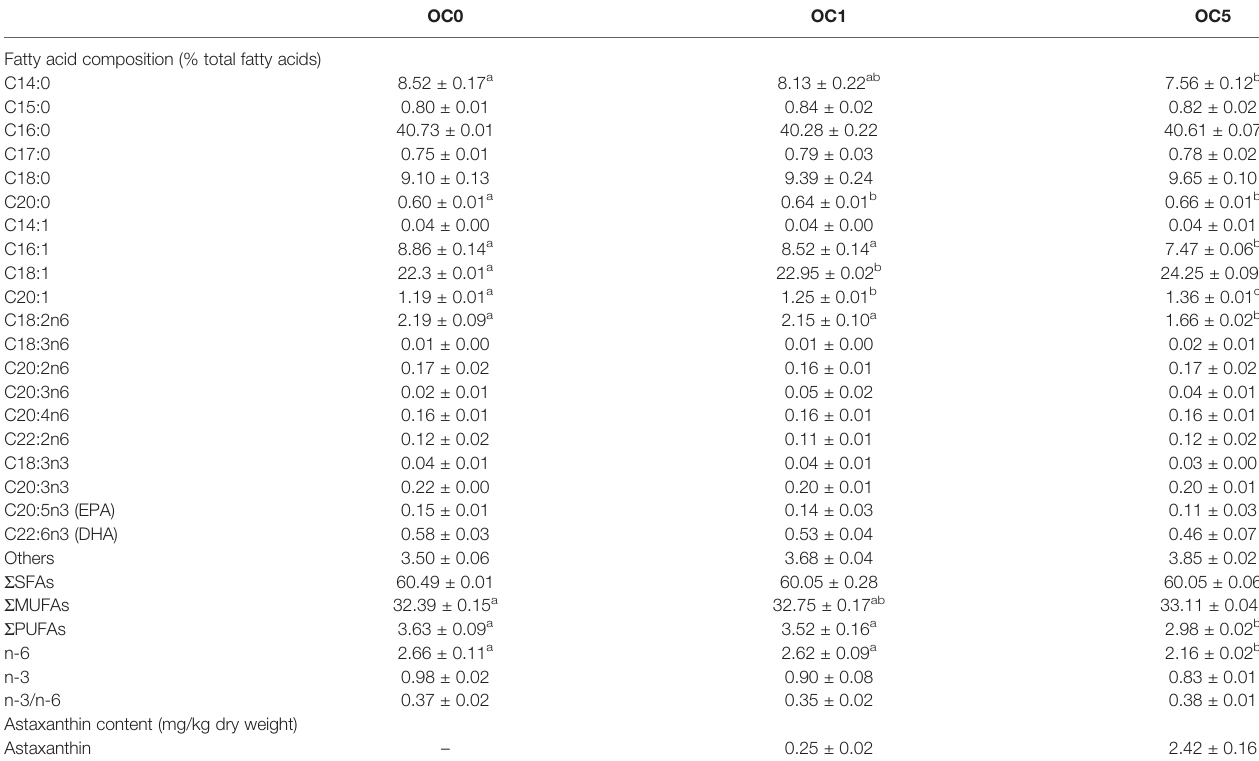
TABLE 2 | Fatty acid composition (% total fatty acids) and astaxanthin content (mg/kg dry weight) in the whole body of Trachinotus ovatus fed with experimental diets. OC0 OC1 Fatty acid composition (% total fatty acids)